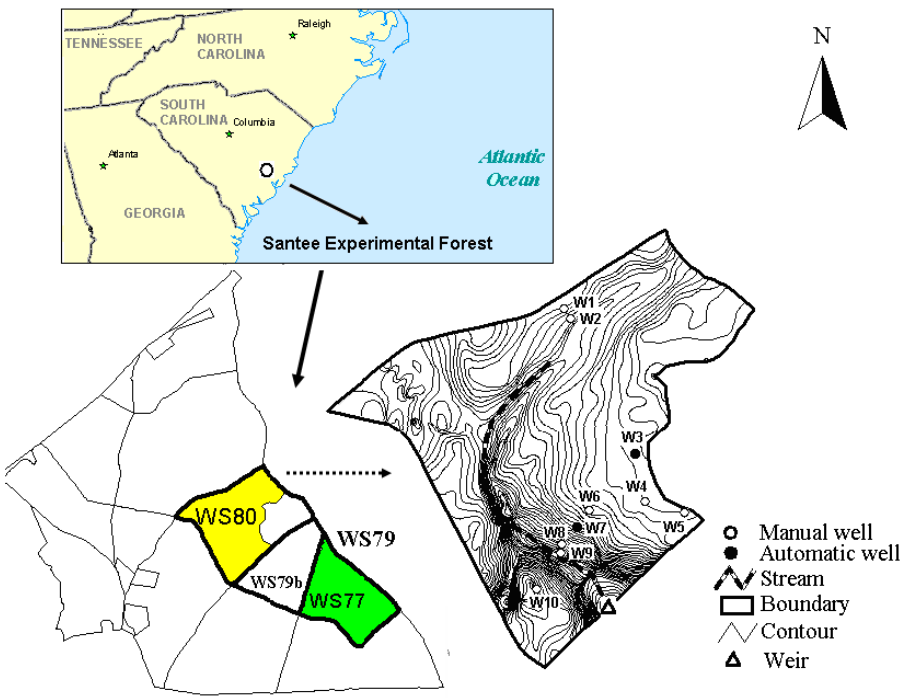
Fig. 1. Location of the study watershed (WS80) on the Santee Experimental Forest, South Carolina, USA. WS80 is 160ha; the location of the groundwater wells is indicated on the topographic map figure as W1 through W10.